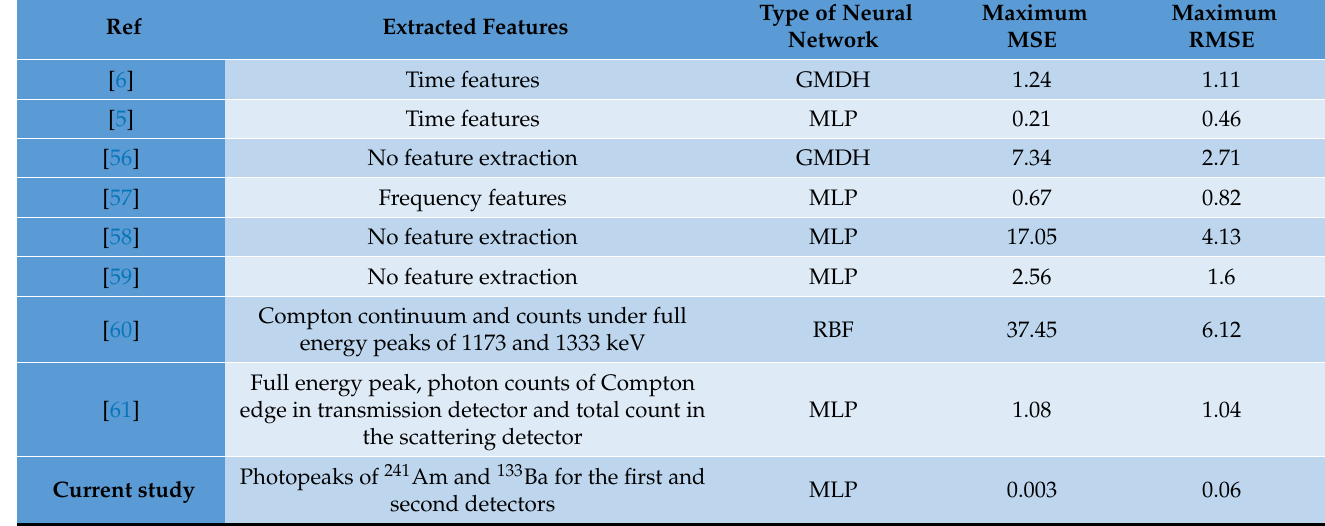
Table 2. A comparison of the accuracy of previous studies and the proposed detection